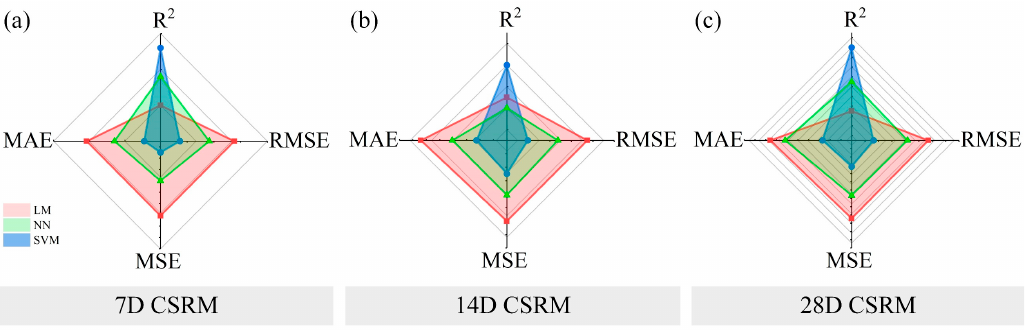
Figure 18. Performances of CS regression models. ( a ) 7D CSRM ( b ) 14D CSRM ( c ) 28D CSRM. Figure 17. Performances of FL, BL, and IST regression models. ( a ) FLRM ( b ) BLRM ( c ) ISTRM.